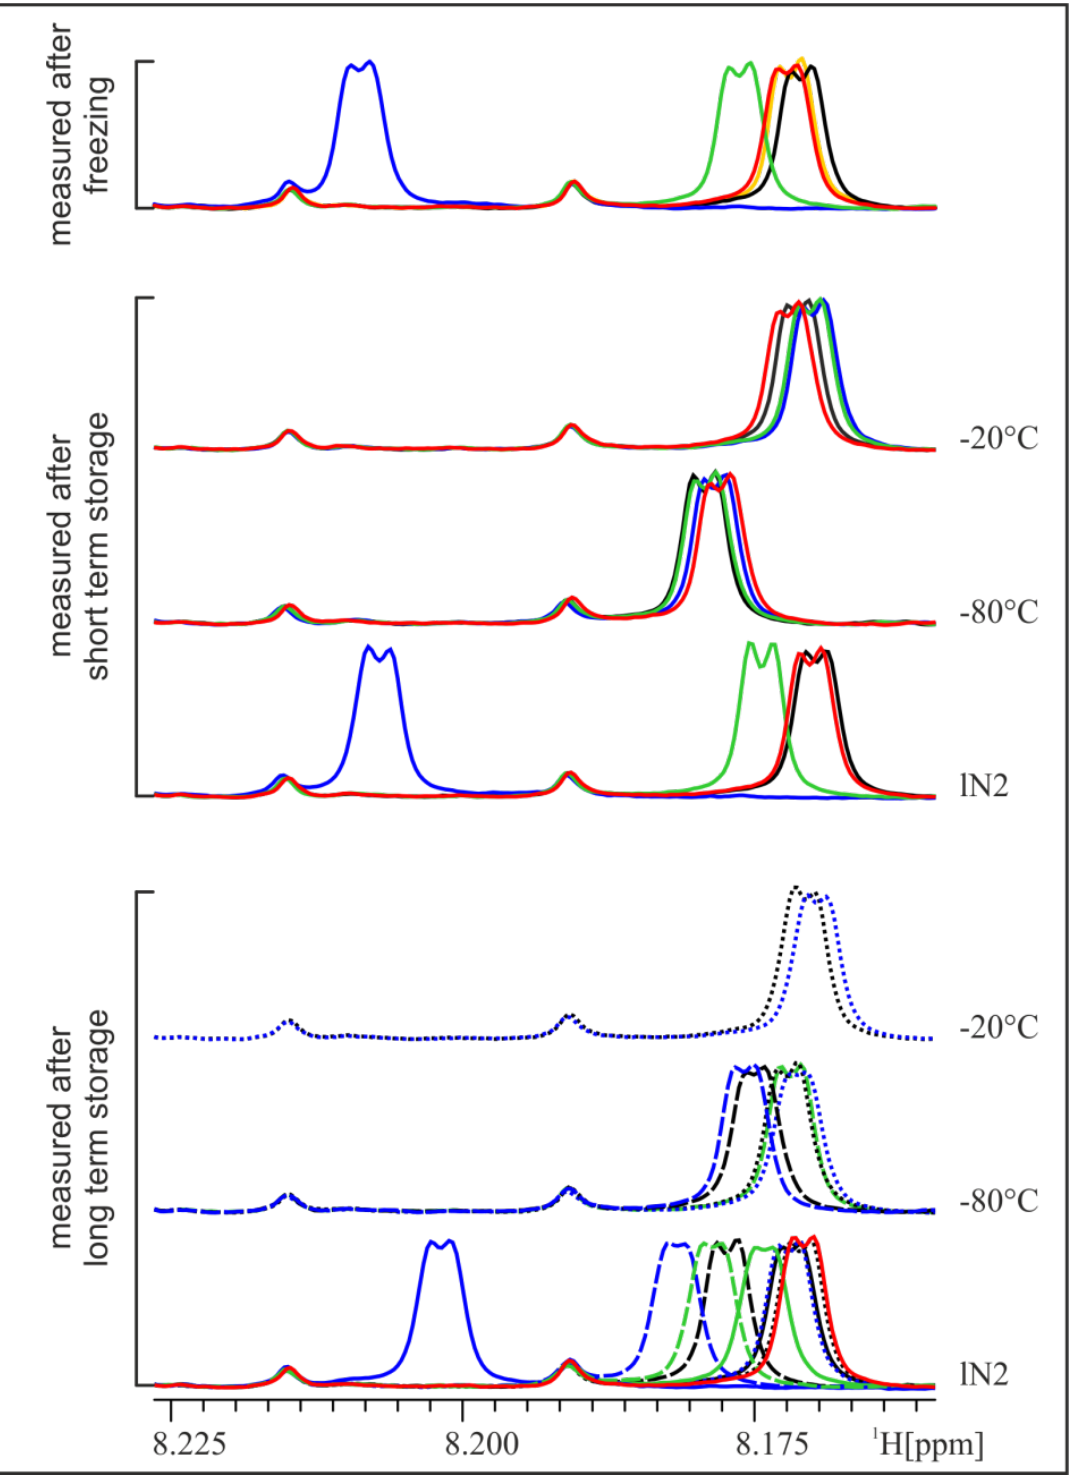
Figure 2. Zoom into pH-sensitive region of NMR spectra of the 24 h urine of a male subject. Samples are colored according to their initial freezing/storage condition (for the legend, see Figure 1) and grouped according to their last storage